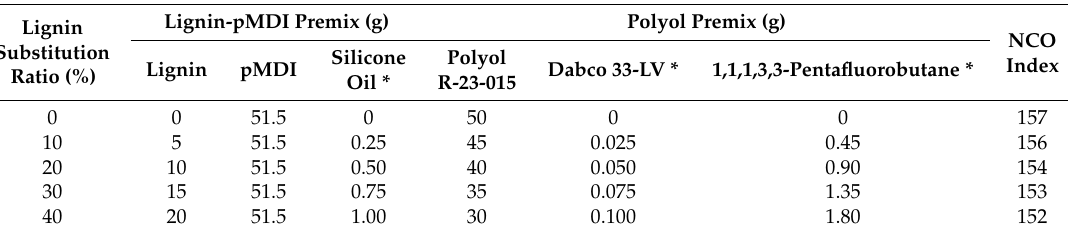
Table 1. Amounts of components used for the preparation of RPU